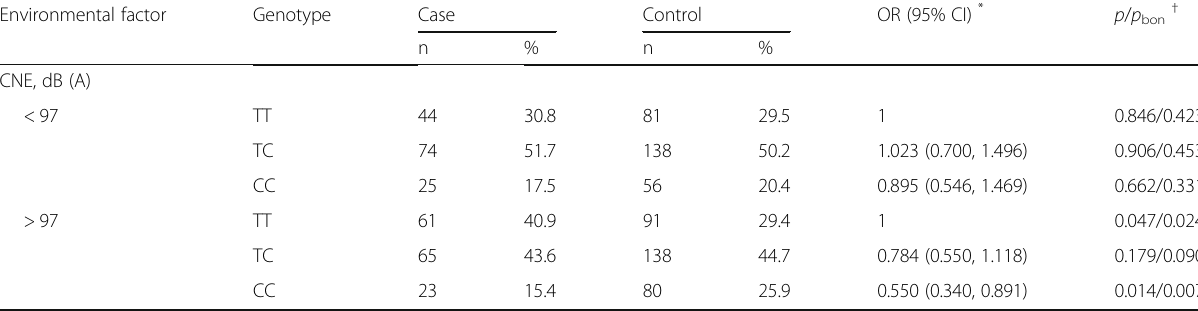
Table 4 Relationship between rs1485175 and NIHL layered by CNE Environmental factor Genotype